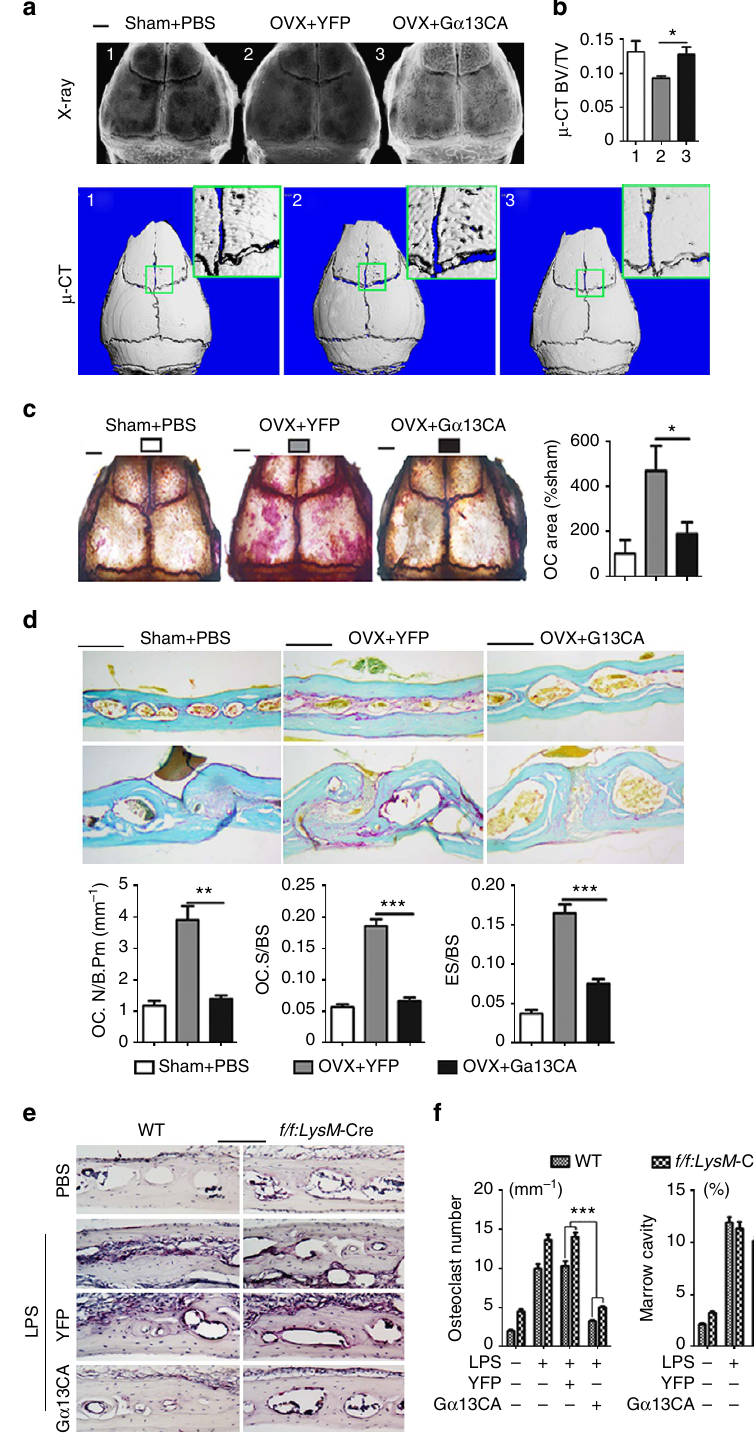
Figure 7 | G a 13 protects mice from OVX- and LPS-induced bone loss. ( a – d ) Histology analysis of calvarial bones from 13-week-old female sham-operated mice (control), and ovariectomized (OVX) mice injected with AAV-YFP or AAV-G a 13CA. ( a ) Radiographic (higher panels) and m -CT analysis (lower panels). High-magnification images are co-presented in the right corners. ( b ) Quantification of bone volume per tissue volume (BV/TV); N ¼ 3. ( c ) Whole calvaria TRAP staining; Quantification of relative TRAP positive area is co-presented on the right panel; N ¼ 4. ( d ) TRAP staining of calvaria frozen sections. Quantification of osteoclast and bone resorption metrics are presented in lower panel; OC.N/B.Pm, osteoclast number per bone perimeter; OC.N/BS, osteoclast number per bone surface; ES/BS, eroded surface per bone surface; N ¼ 4. ( e ) TRAP staining using frozen sections of calvarial bones from 8-week-old male WT and Gna13 f/f LysM -Cre ( f/f;LysM- Cre) mice treated with PBS, LPS, LPS þ AAV-YFP or LPS þ AAV-G a 13CA. ( f ) Quantification of TRAP-positive cells per bone surface and marrow cavity area in e ; N ¼ 6. Results were expressed as mean ± s.d.; * P r 0.05; ** P r 0.01; *** P r 0.001 (Student’s t -test or ANOVA analysis). scale bars in a , c 200 m m; scale bars in d , e ,